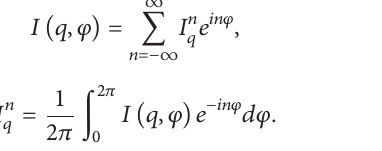
,𝑞 , 𝑞 ,Δ , Δ ) 1 2 3 1 2